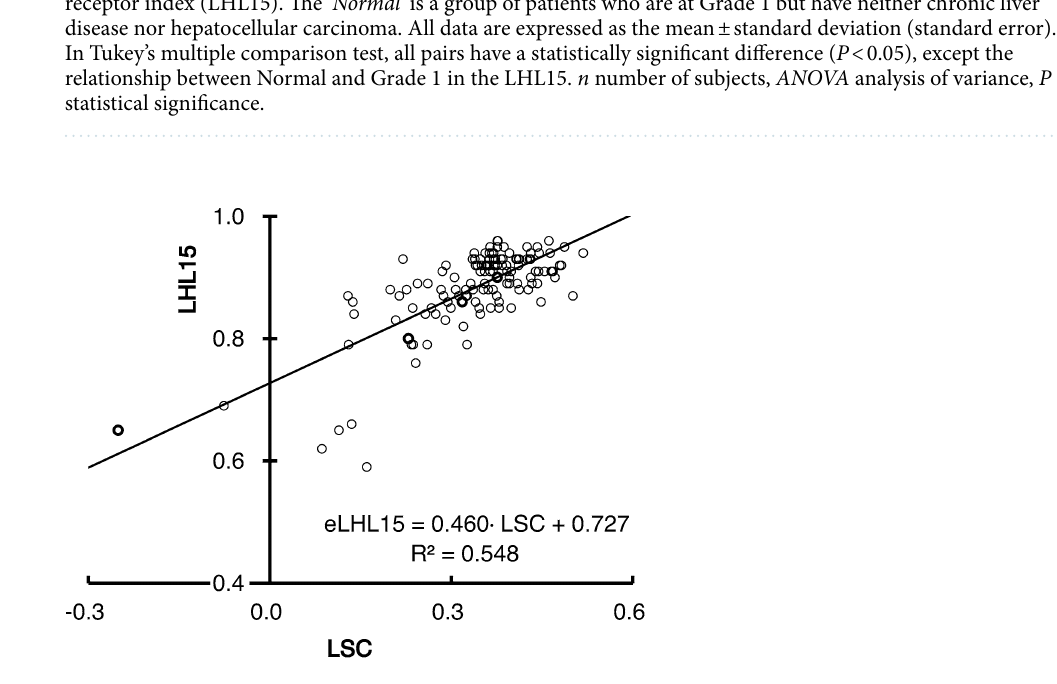
Figure 3. Relationship between the LSC and LHL15. The black line represents the regression line of the LSC and LHL15.